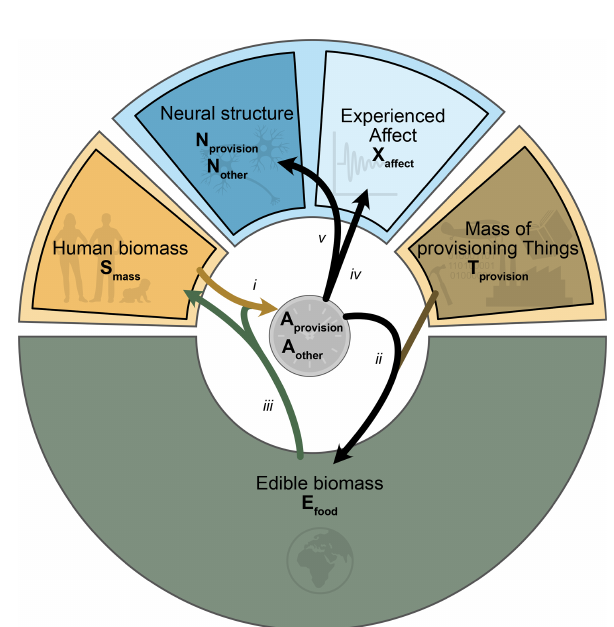
Figure 3. Model architecture, shown within the conceptual frame- work of Fig. 2. Dependencies are shown as arrows: (i) food